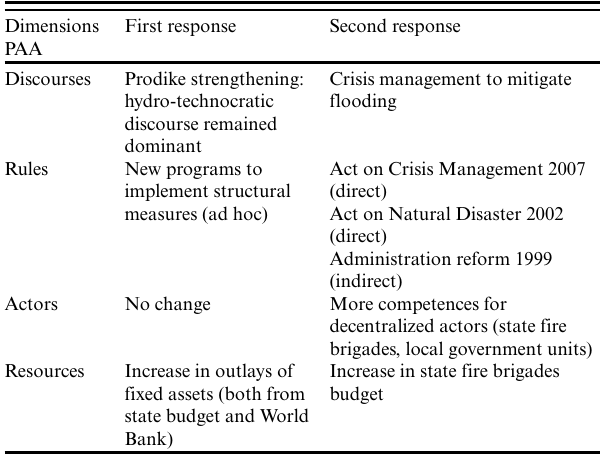
Table 9 . Institutional consequences after the flood of 1997. PAA = policy arrangement